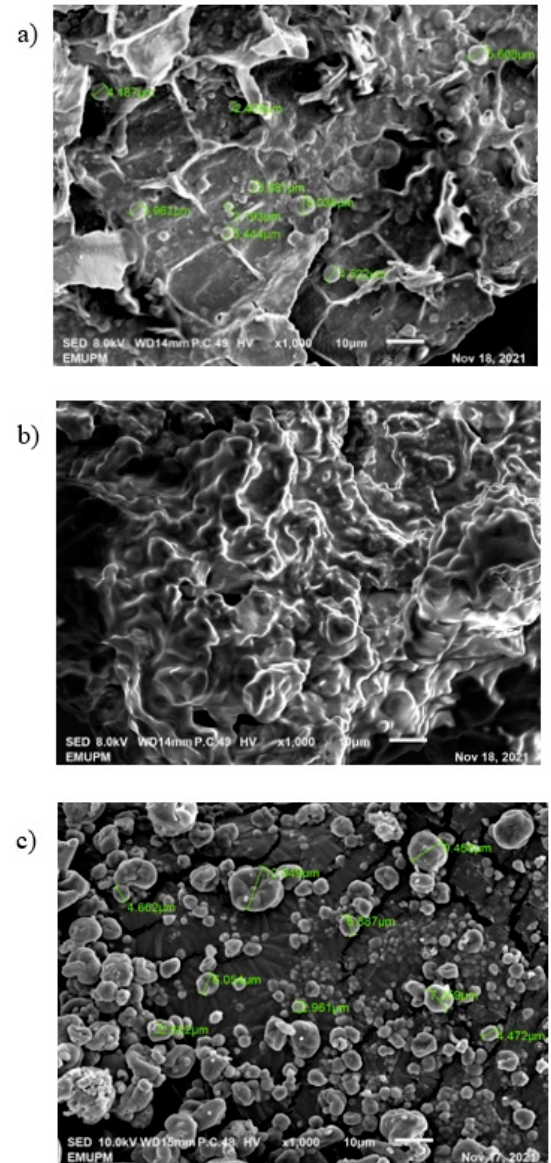
Figure 6. SEM micrograph for RBP powder produced with the different drying methods at 1000 × magnification, ( a ) freeze drying, ( b ) oven drying, and ( c ) spray-drying.